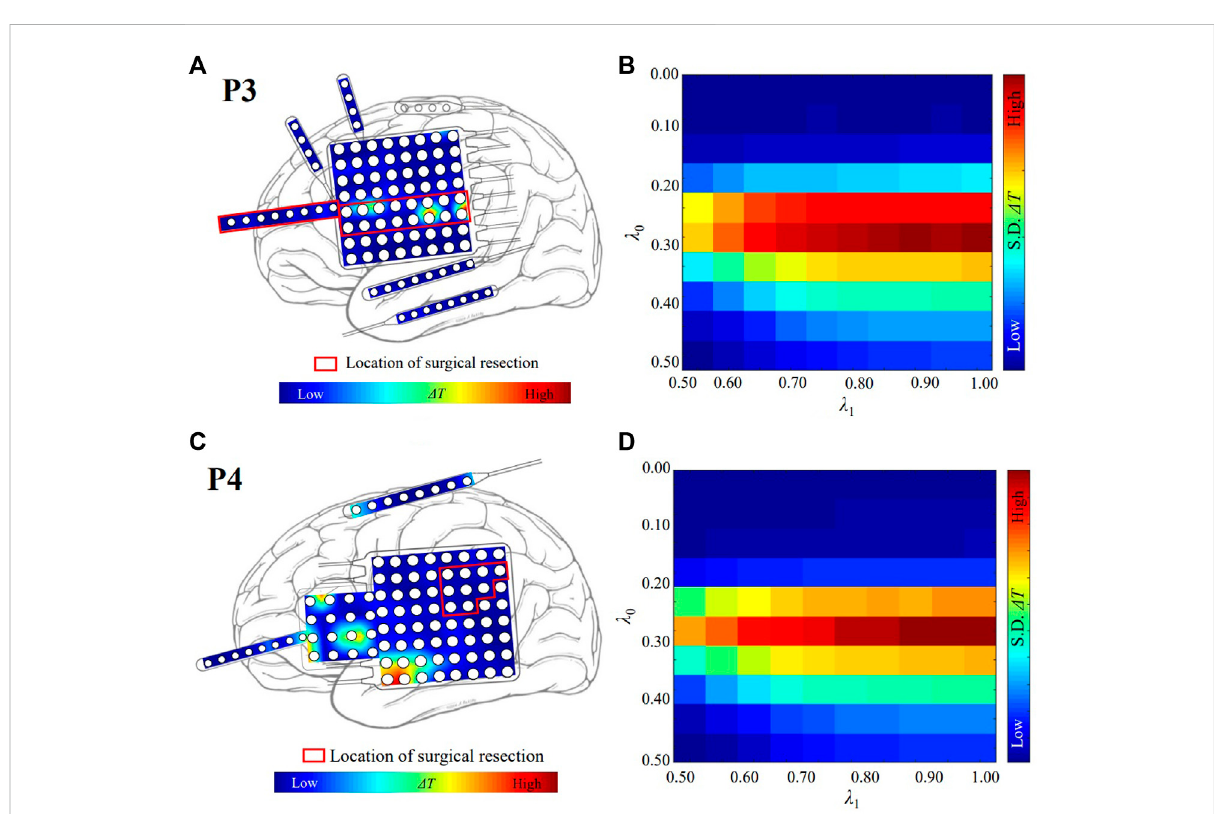
FIGURE 3 ThelocalizedtargetsforneuromodulationofpatientP3andP4. (A) Thedistributionof Δ T forpatientP3.Thewhitecirclesrepresentthecontacts oftheelectrodes.Redandblueindicatethemagnitudeofthevalueof Δ T .Theredcolorindicatesthatthevalueof Δ T islarge.Thebluecolorindicates that the value of Δ T is small. (B) The optimal value of λ for patient P3. λ 0 = 0.30 and λ 1 = 1.00. The red color indicates that the value of standard deviation (S. D.) of Δ T is large. (C) The distribution of Δ T for patient P4. (D) The optimal value of λ for patient P4. λ 0 = 0.30 and λ 1 =